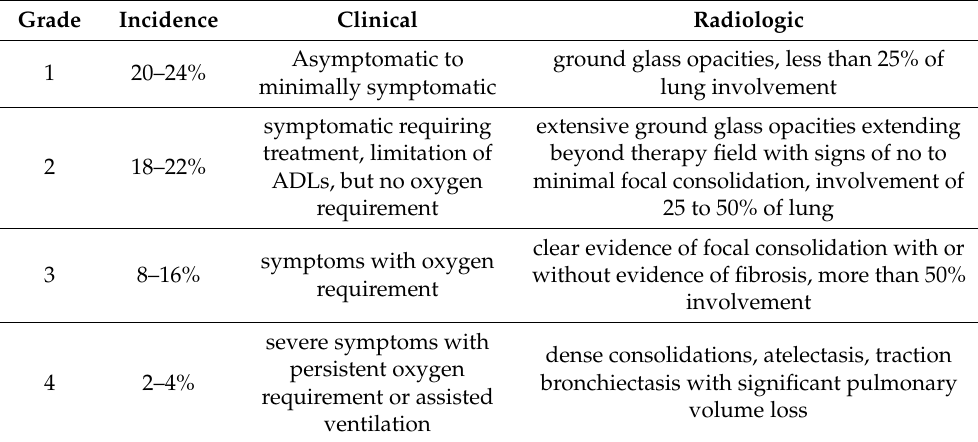
Table 2. Common Terminology Criteria for Adverse Events version 5.0 for pneumonitis